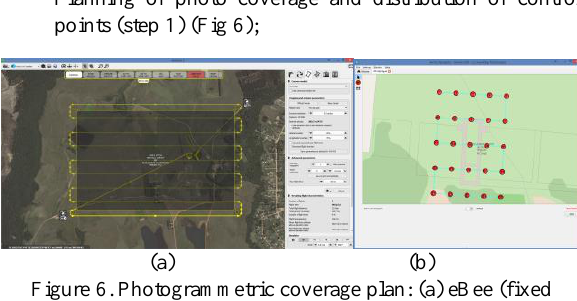
Figure 6. Photogrammetric coverage plan: (a) eBee (fixed